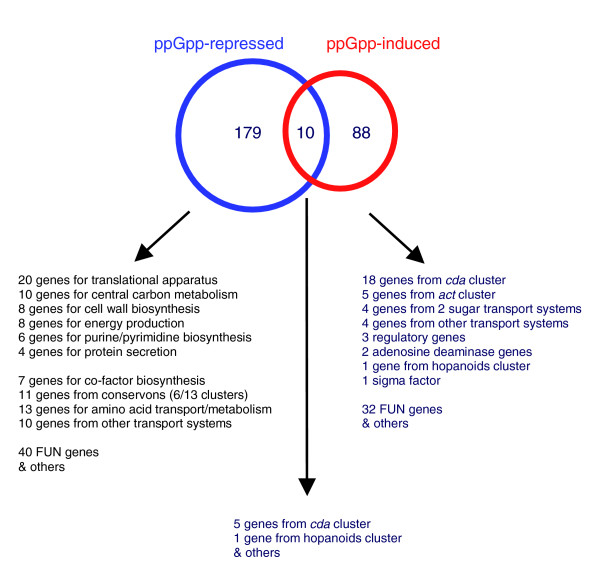
Induction of ppGpp synthesis in S. coelicolor represses genes associated with active growth, but stimulates transcription from the act and cda antibiotic clusters.